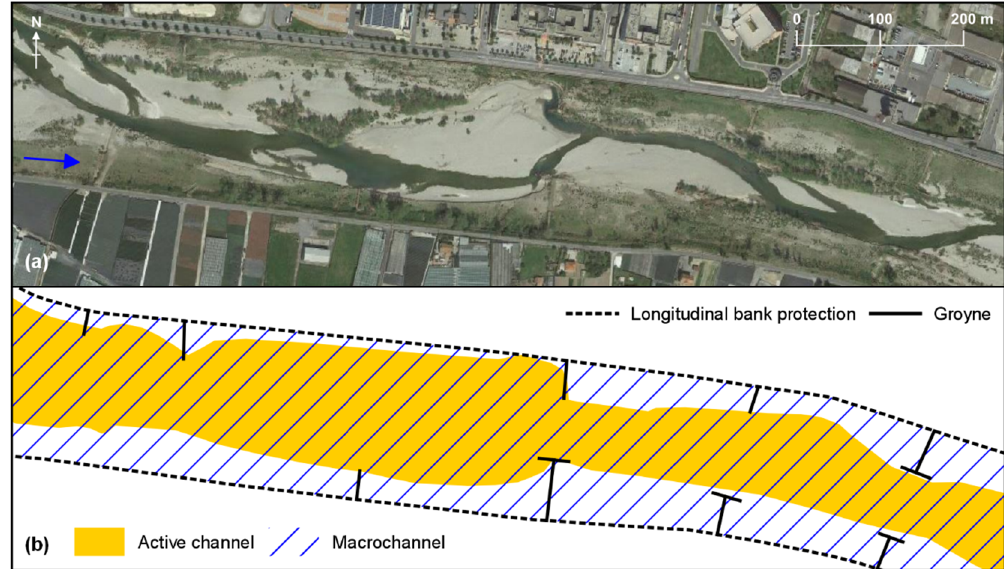
Figure 3. Active channel and macrochannel definition: ( a ) Google Earth image dated back to 2020 showing the Centa River upstream of Albenga and ( b ) the corresponding sketch of bank protections, active channel, and macrochannel. The blue arrow indicates the flow direction.